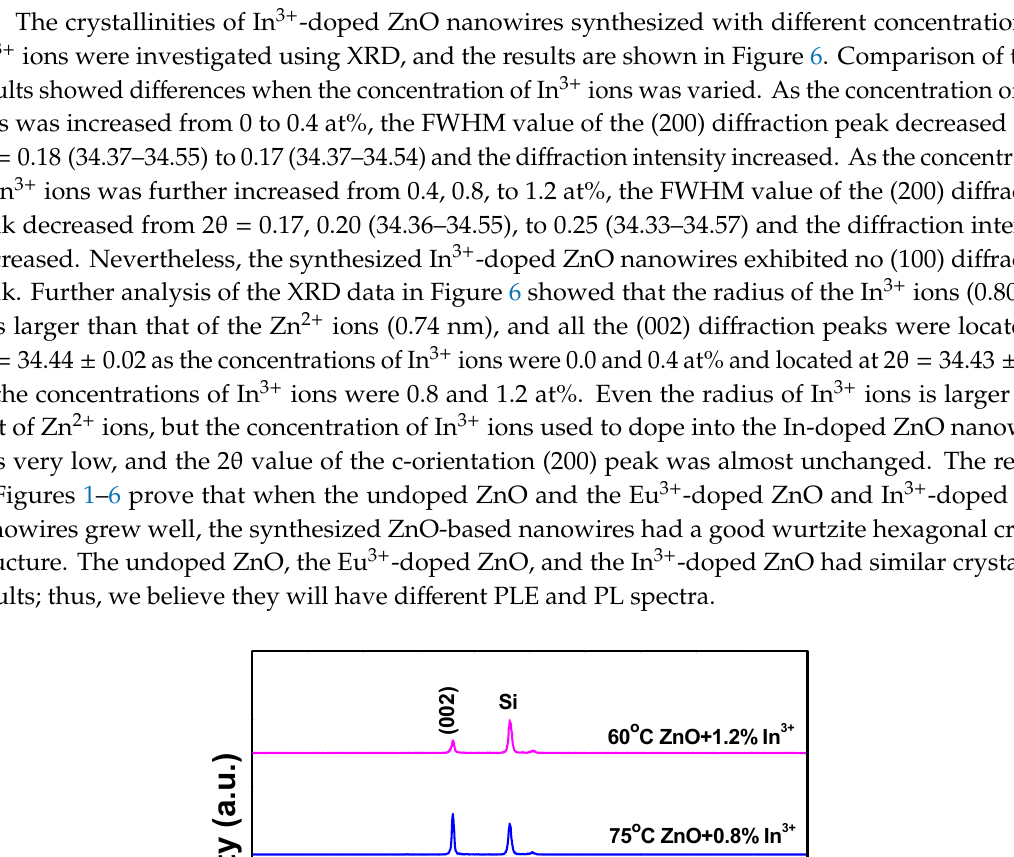
Figure 5. XRD patterns of the synthesized Eu 3+ -doped ZnO nanowires as a function of the concentration of Eu 3+ ions (or synthesis temperature).